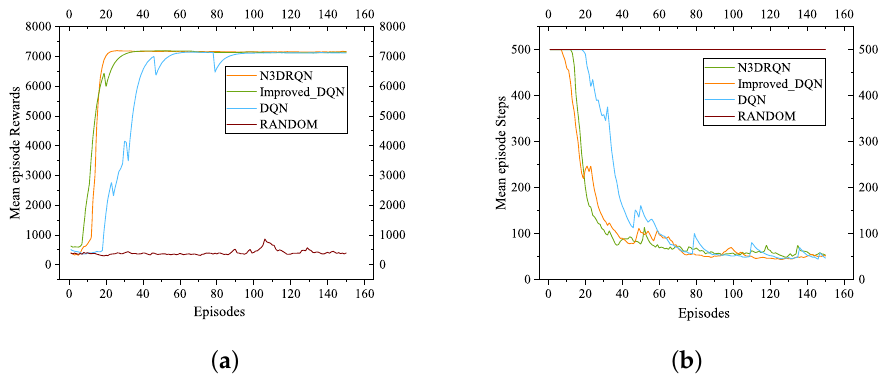
Figure 3. Mean rewards versus training episodes in the Chain-10 environment. ( a ) Mean episode reward in the Chain-10 environment. The horizontal axis represents the cumulative number of episodes used by the agent to execute the action. The vertical axis represents the cumulative rewards as the agent interacting with the environment. ( b ) Mean episode steps in the Chain-10 environment. The horizontal axis represents the cumulative number of episodes used by the agent to execute the action. The vertical axis represents the number of steps decided by the agent per episode.